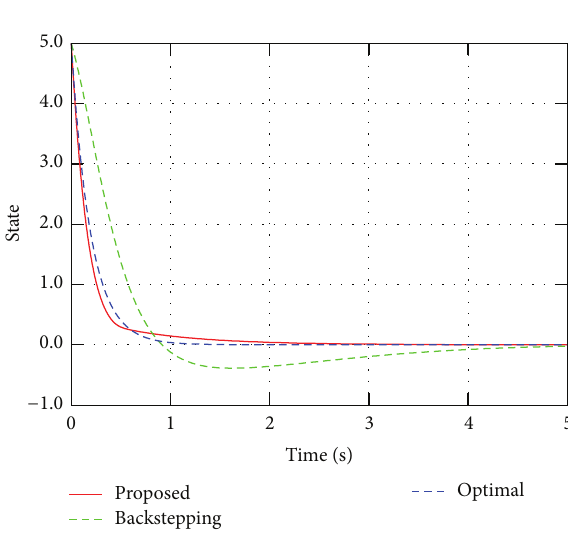
Figure 2: Time histories of 𝑥 2 (𝑡)